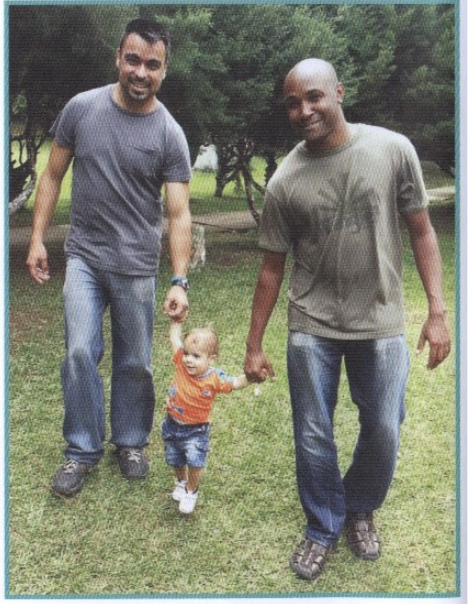
Figure 9 . Closing image that appears with information about the author at the end of the book.